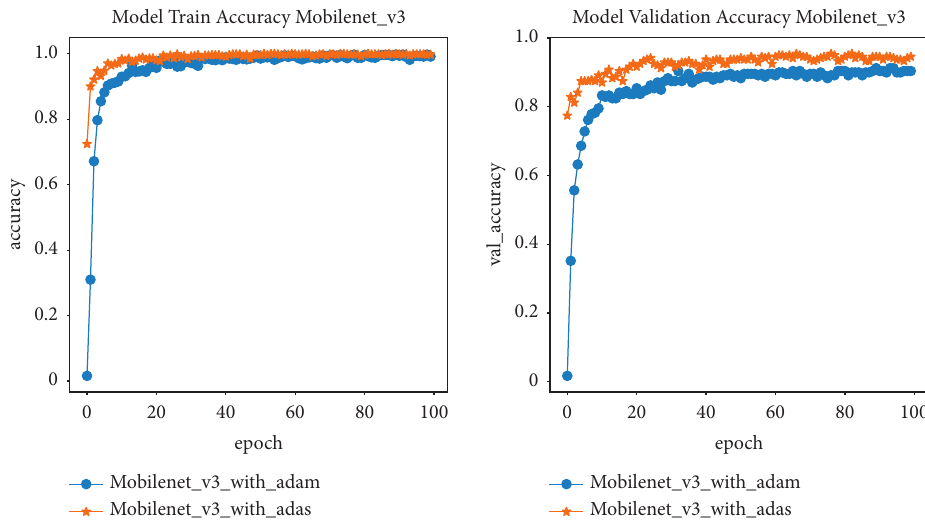
Figure 19: Accuracy of MobileNetV3 network architectures using ADAM and ADAS optimization